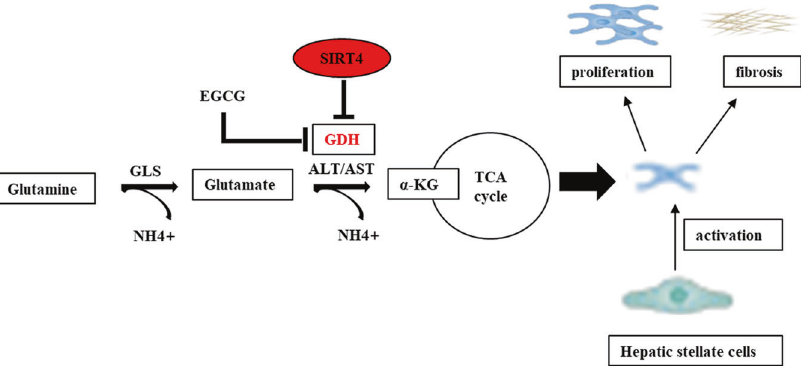
Fig. 7 Graphical abstract. SIRT4 controls GDH enzyme activity, targeting glutamine metabolism in HSCs, inhibiting the activation and proliferation of HSCs, and ultimately alleviating liver fi brosis. Glutamine metabolic pathway: Glutamine is catalyzed by mitochondrial glutaminase (GLS) to produce glutamate and NH4 + ; Glutamate is converted into α -Ketoglutaric acid ( α -KG) under the catalysis of GDH and enters the tricarboxylic acid (TCA) cycle, providing energy for the rapidproliferation of